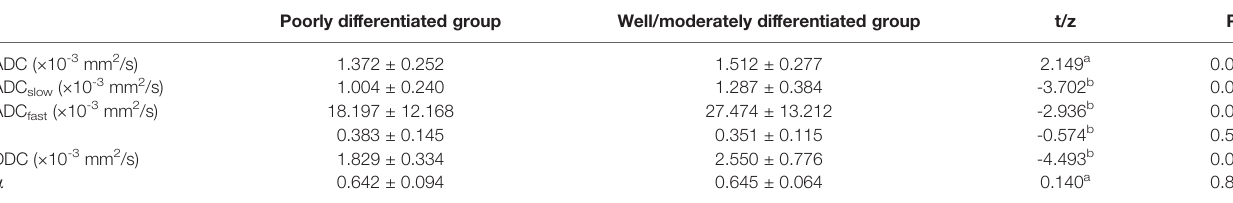
TABLE 2 | Comparison between poorly and well-/moderately differentiated group of different